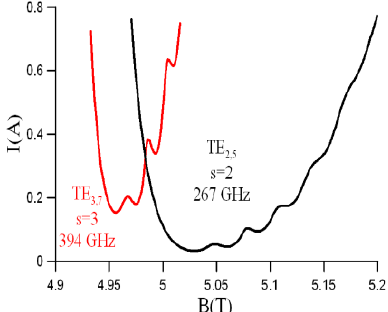
Fig. 1. Calculated values of the starting currents of modes TE3.7 and TE2.5 at the third and second harmonics, respectively.